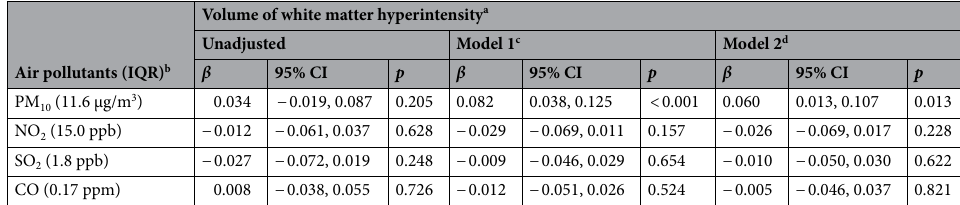
Table 2. Linear regression analysis results for the association between white matter hyperintensity and air pollution. IQR, interquartile range; CI, confidence interval; PM 10 , particulate matter ≤ 10 μm in diameter; NO 2 , nitrogen dioxide; SO 2 , sulfur dioxide; CO, carbon monoxide. a Volume of white matter hyperintensity was square root-transformed to achieve normality. b The β coefficients and standard error in each air pollutant was scaled to the interquartile range for each pollutant, respectively (11.6 μg/m 3 for PM 10 , 15.0 ppb for NO 2 , 1.8 ppb for SO 2 , and 0.17 ppm for CO). c Model 1 was adjusted for age, sex, body mass index. d Model 2 was adjusted for Model 1 plus hypertension, diabetes mellitus, and